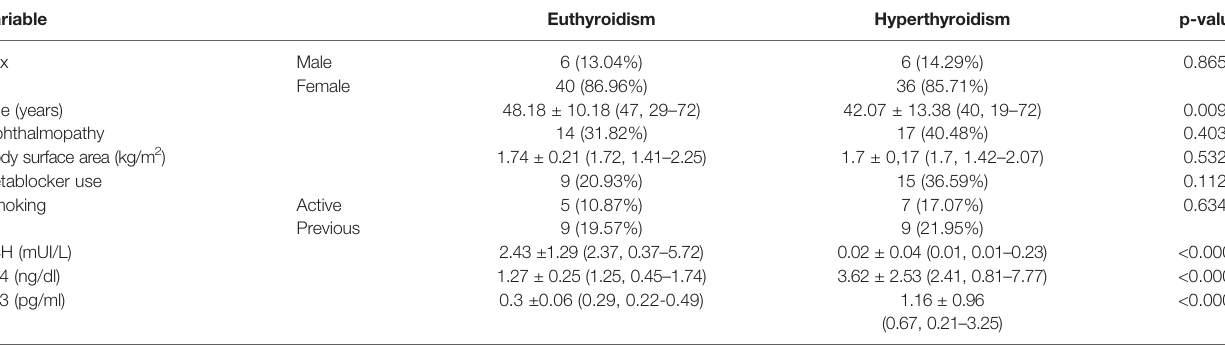
TSH, thyroid-stimulating hormone; FT4, free thyroxine; FT3, free tri-iodothyronine. Categoricalvariablesarerepresentedbytheabsolutevalueandfrequencyinpercentage.Continuousvariablesarerepresentedbyvaluesofmean±standarddeviation(median,minimum, and maximum).